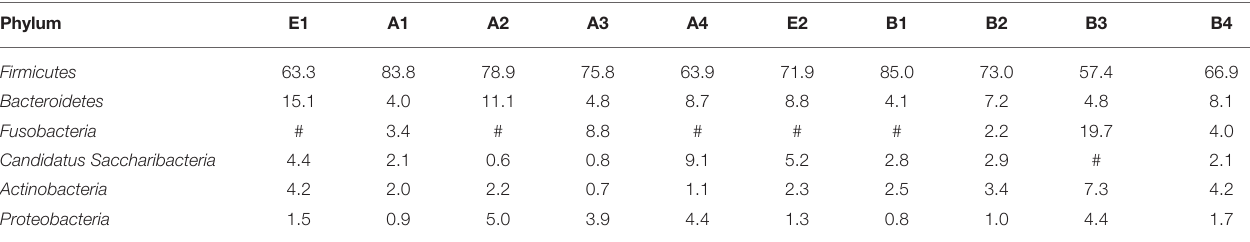
TABLE 7c | Relative abundance of species at the phylum level of intestinal microflora structure in mice (%).